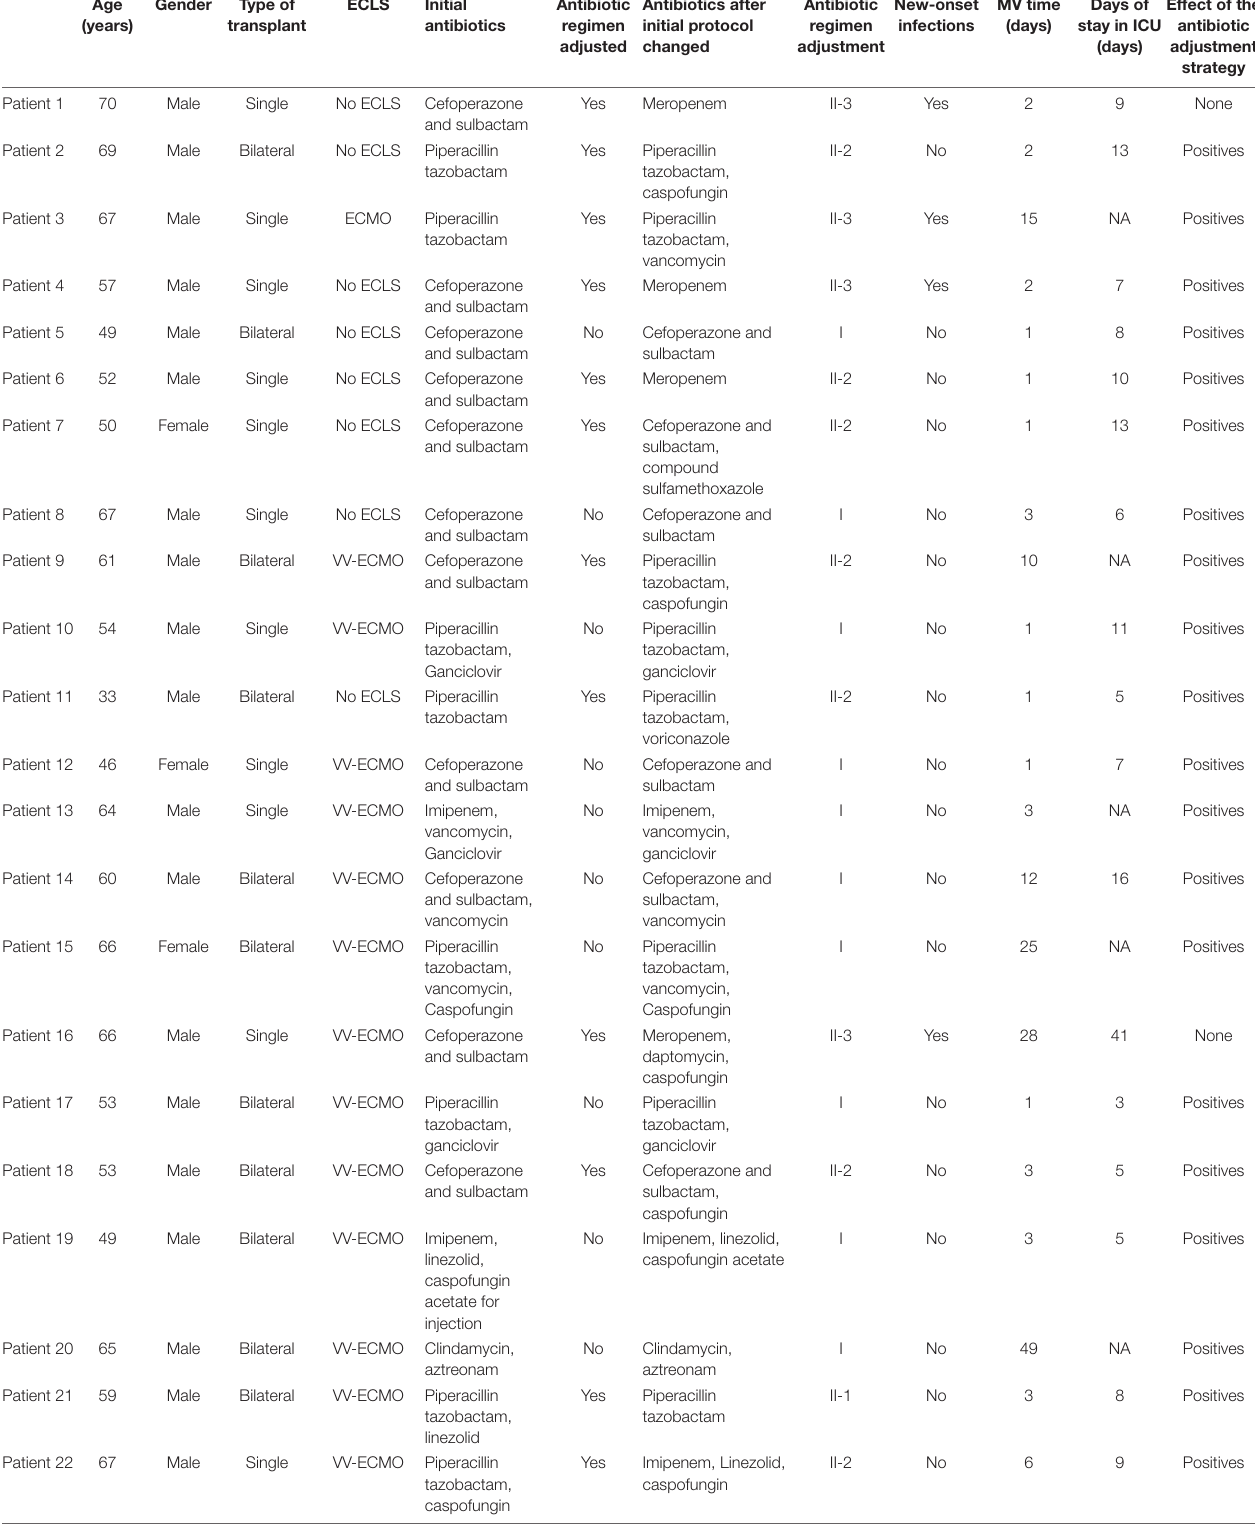
TABLE 2 | Characteristics of individual transplant